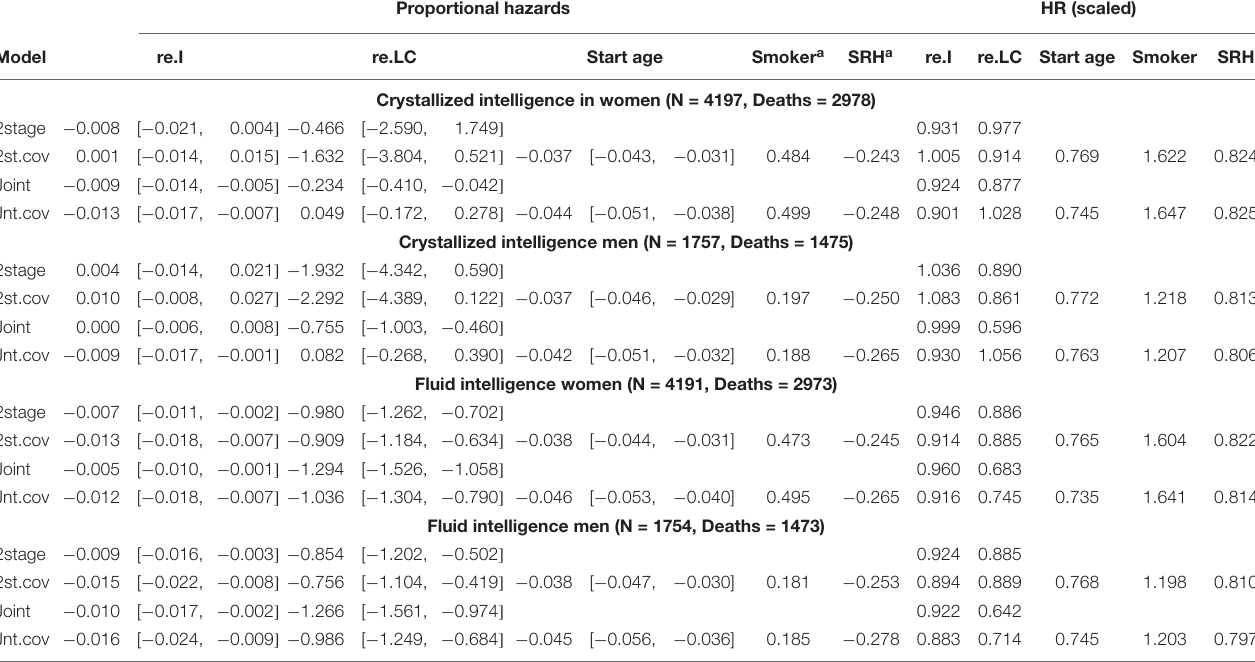
TABLE 7 | Cognition-survival associations (all